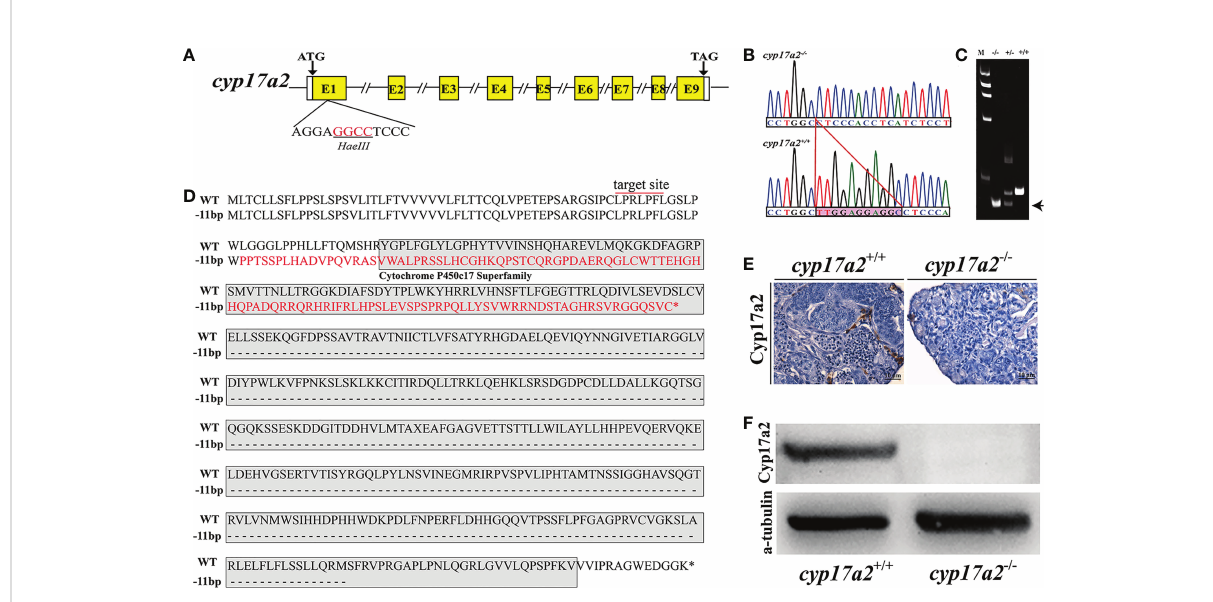
FIGURE 2 Establishment of cyp17a2 -null mutation line by CRISPR/Cas9. (A) , Gene structure of cyp17a2 gene with the target site and the underlined restriction enzyme ( Hae III) cutting site. (B) , A deletion of 11 bp (TTGGAGGAGGC) in the genome of cyp17a2 -/- fi sh compared with cyp17a2 +/+ fi sh was detected by Sanger sequencing analysis and the deletion region was highlighted by a pink shading. (C) , Mutations in the cyp17a2 gene were detected by polyacrylamide gel electrophoresis. Wild type (+/+), heterozygous (+/-), and homozygous (-/-) fi sh were screened via PCR and PAGE gel electrophoresis. M, marker; Arrow, homoduplex of mutants (D) , A putative truncated protein was produced in cyp17a2 -/- fi sh (-11 bp) compared with cyp17a2 +/+ fi sh (WT). Red line, target site; Red letters, putative amino acids in cyp17a2-/- fi sh; Gray shading, Cytochrome P450c17 Superfamily domain. Asterisk, termination of protein. (E, F) Cyp17a2 expression was not detected in the testes of cyp17a2 -/- fi sh according to IHC and Western blotting